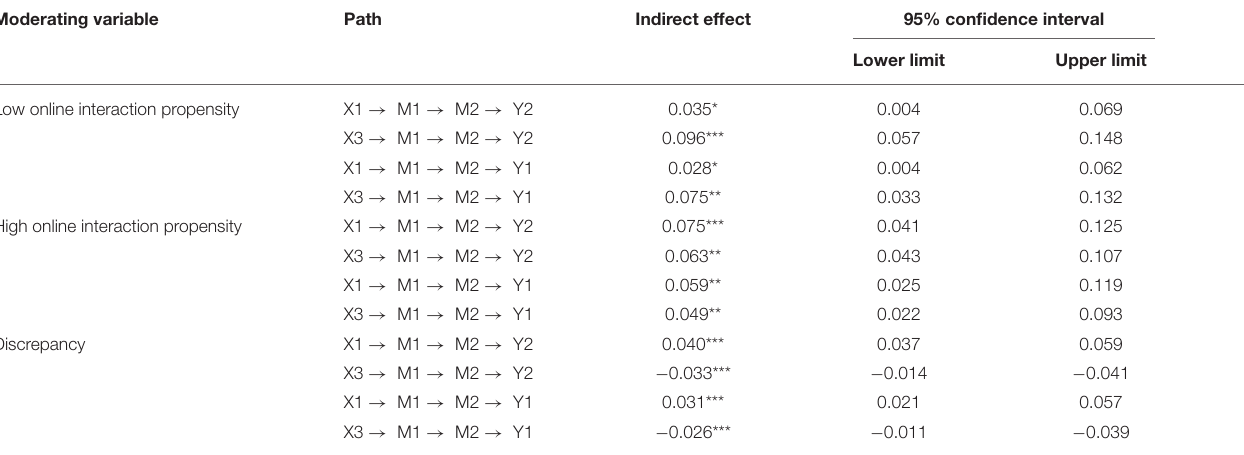
TABLE 4 | Moderated chain-mediated effect